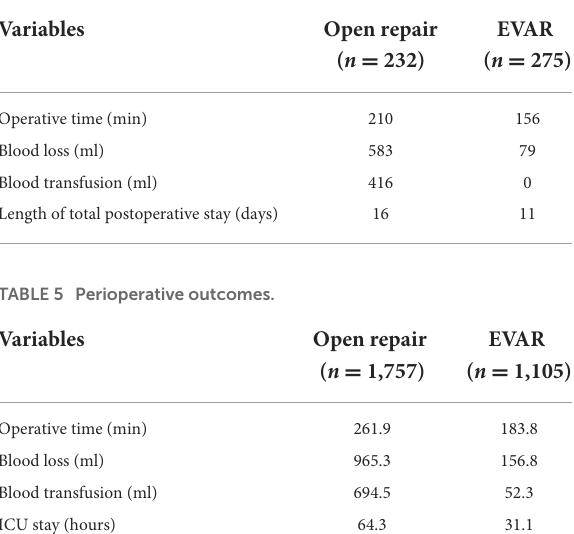
TABLE 6 Postoperative long-term follow-up